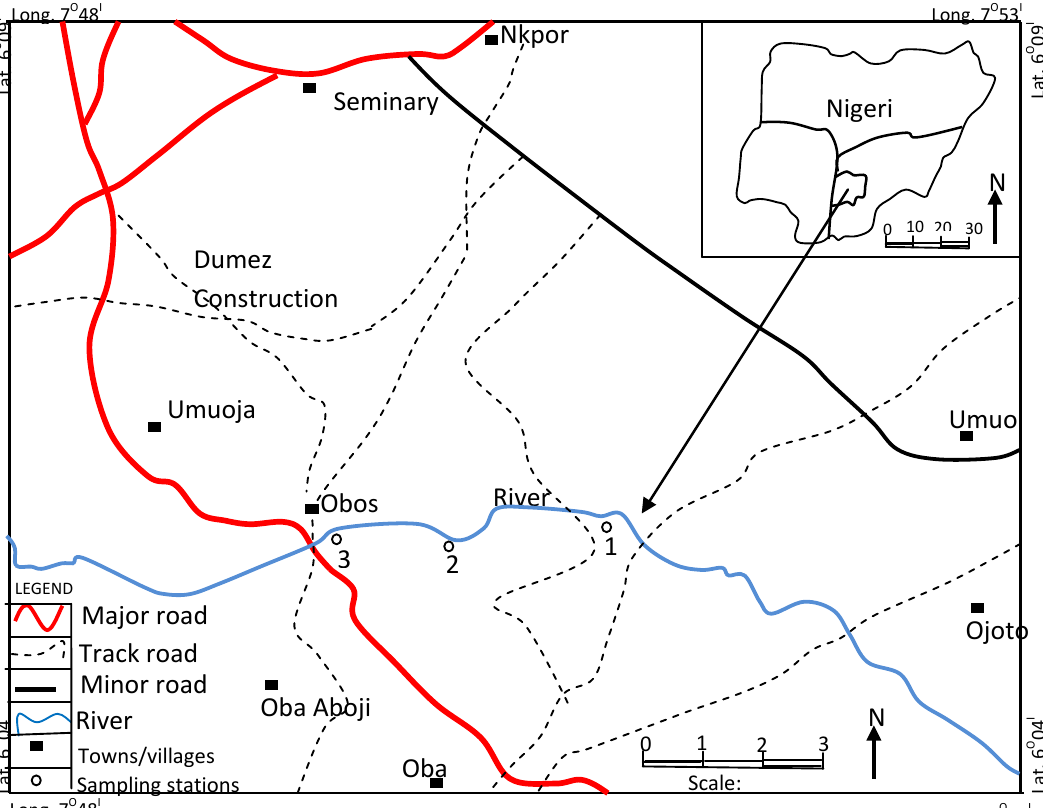
Fig.1. River Idemili, Obosi section showing sampling stations (inset: map of Nigeria showing the study